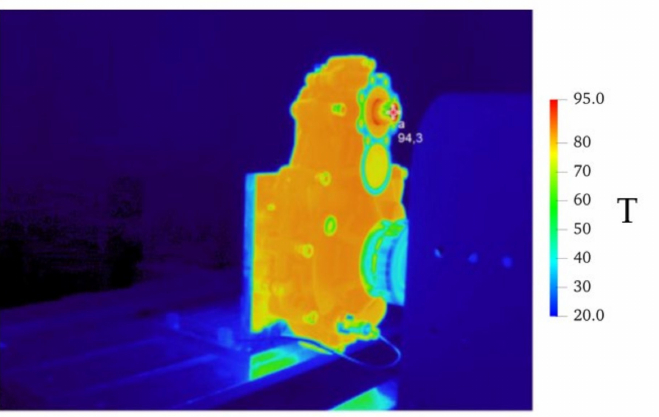
Figure 8. Temperature map of the gearbox measured by a thermal